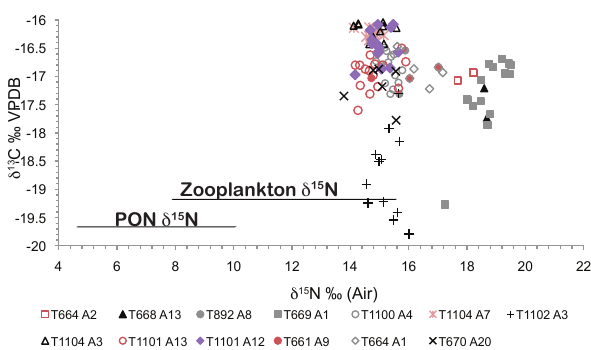
Figure 4. Stable isotopic ( δ 15 N, δ 13 C) composition for samples from 13 coral specimens. Symbols follow the key, and are the same symbols used in Fig. 2 (live corals: red symbols; dead corals: black or grey symbols). Typical PON and zooplankton δ 15 N ranges from the California Current are provided for comparison (see text for ref- erences); these ranges do not represent typical POM δ 13 C values, which can range from − 15 to − 21‰ (based upon copepod organic matter from the California Current; Miller et al.,